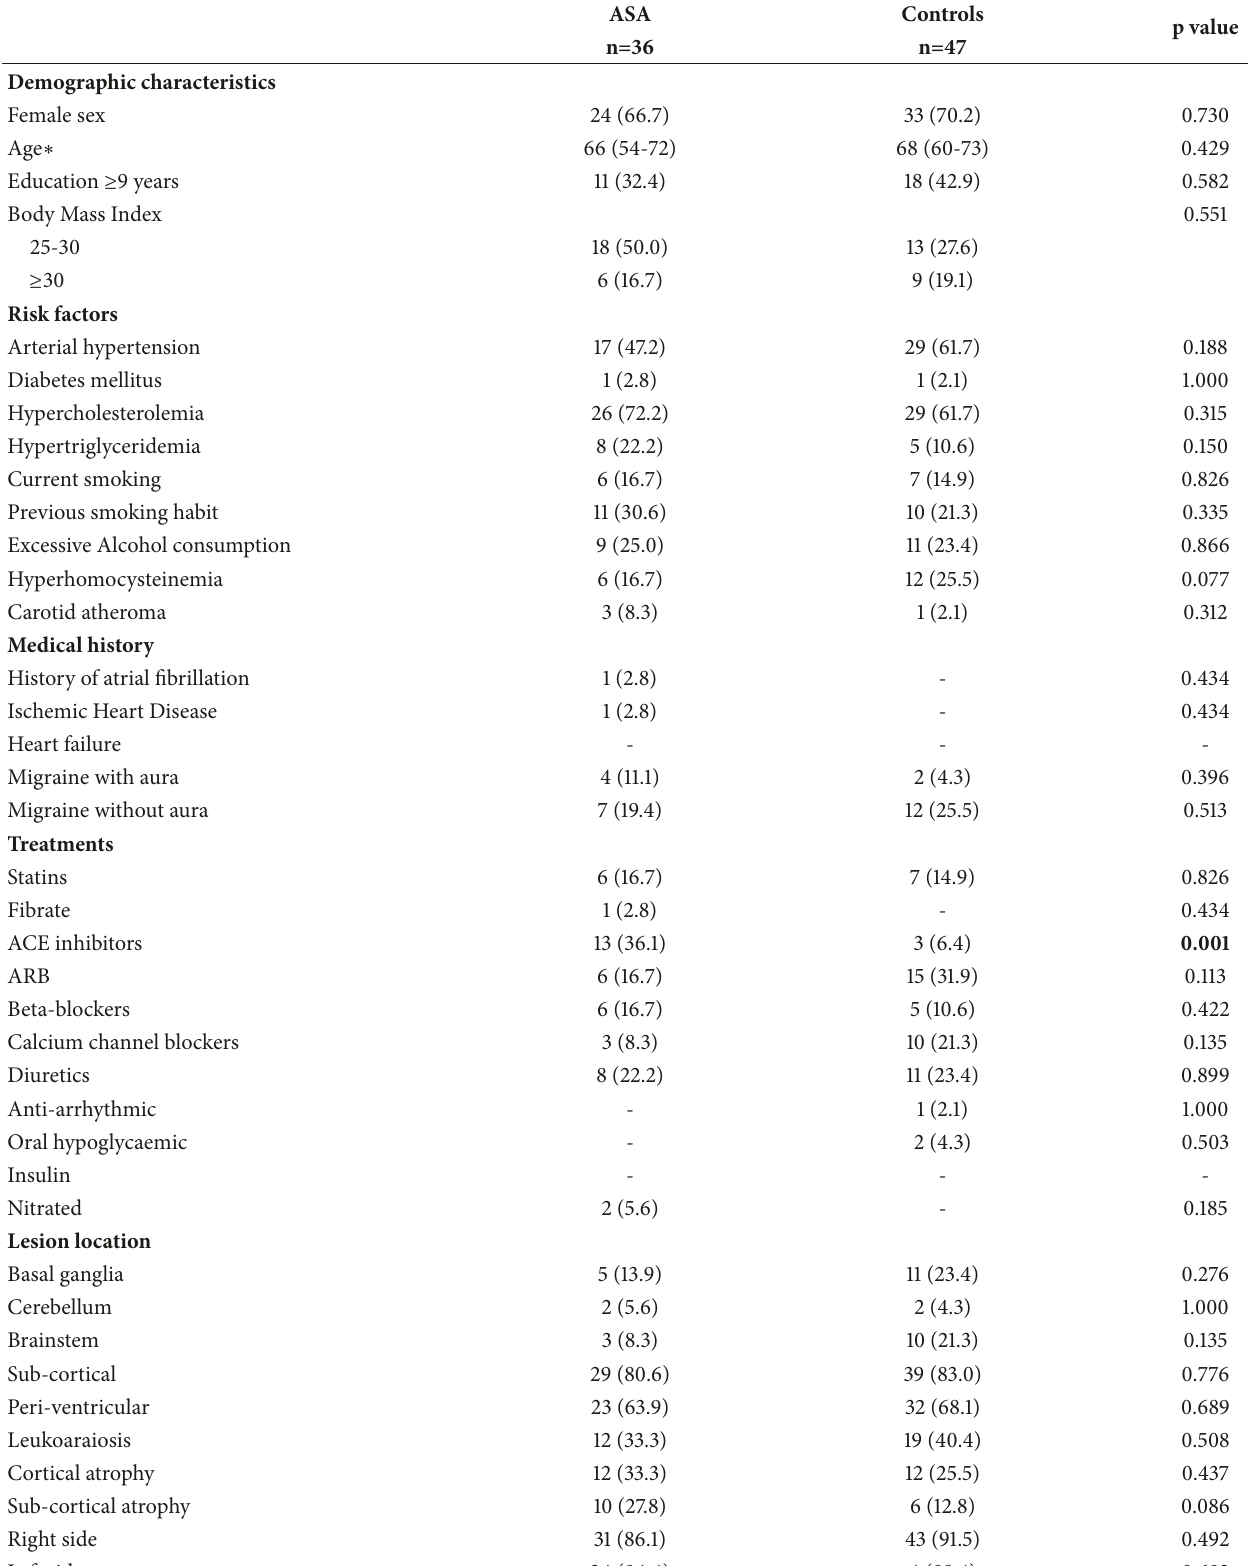
Table 1: Baseline demographical and clinical characteristics of the study population (n=83) and bivariate comparison between patients treated and not treated . ∗ Value given as median (interquartile range). All other data are reported as absolute number of subjects